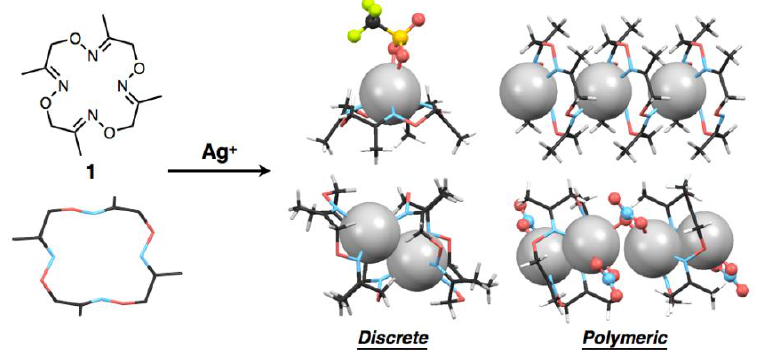
Figure 1. Schematic representation of the formation of four types of Ag I complexes of 1 with discrete or polymeric